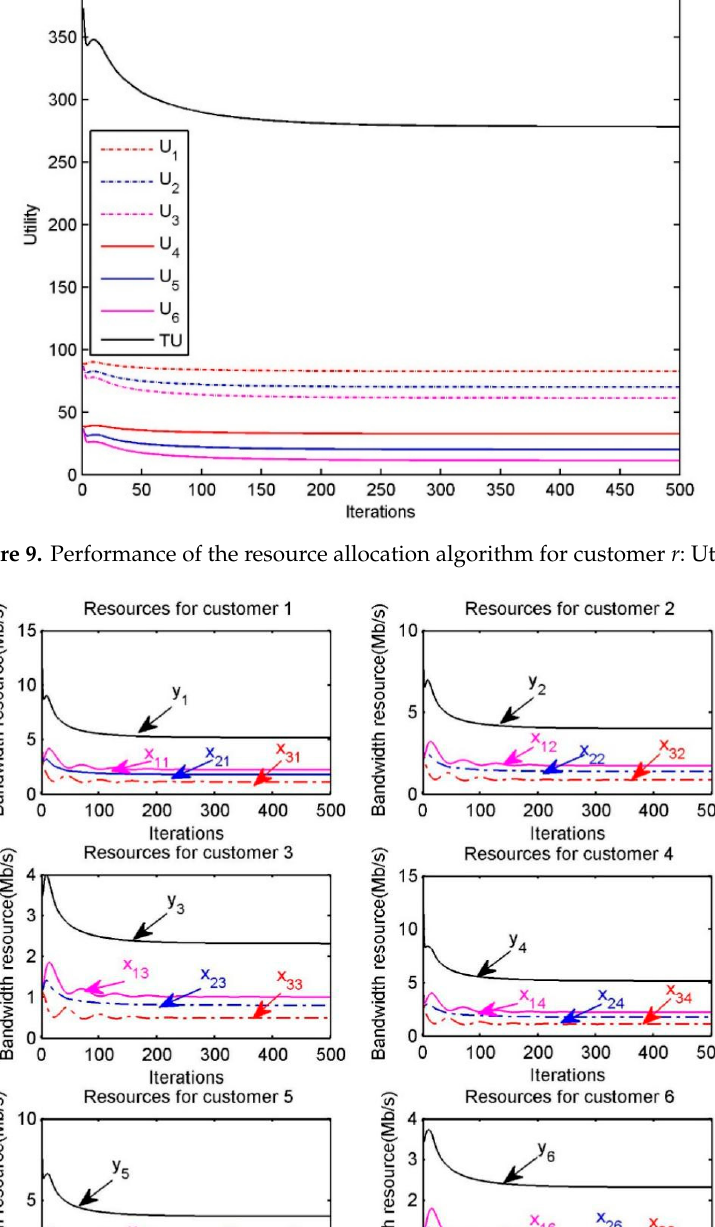
Figure 10. Optimal bandwidth resource allocation for customer 𝑟 .